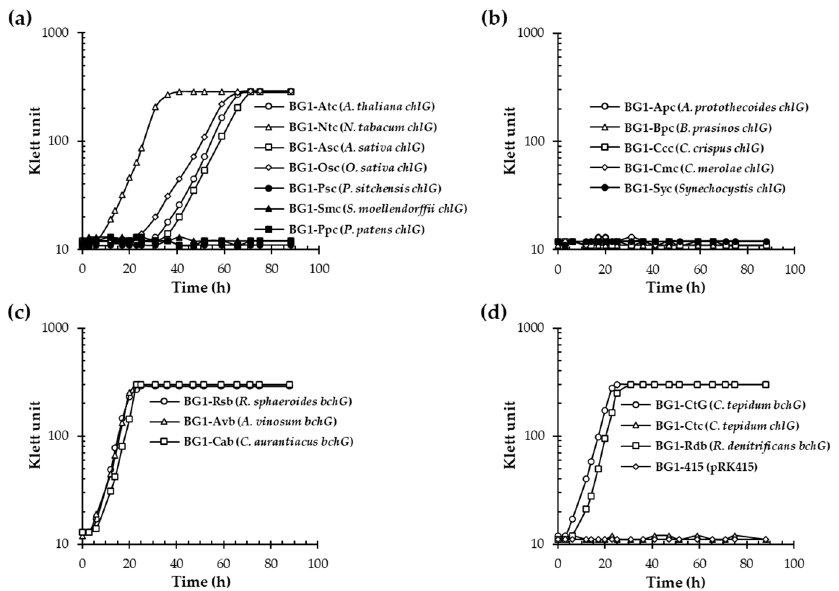
Figure 4. Photoheterotrophic growth of BG1 expressing bchG s and chlG s from various PS organisms. The growths of BG1 expressing chlG of plants ( a ), chlG of algae and cyanobacterium ( b ), and bchG / chlG of PS bacteria ( c , d ) were recorded. BG1-Rsb and BG1-415 were included as controls. Geranylgeranyl reductases (BchP and ChlP) reduce Chl a GG to produce Chl a P . Alter-